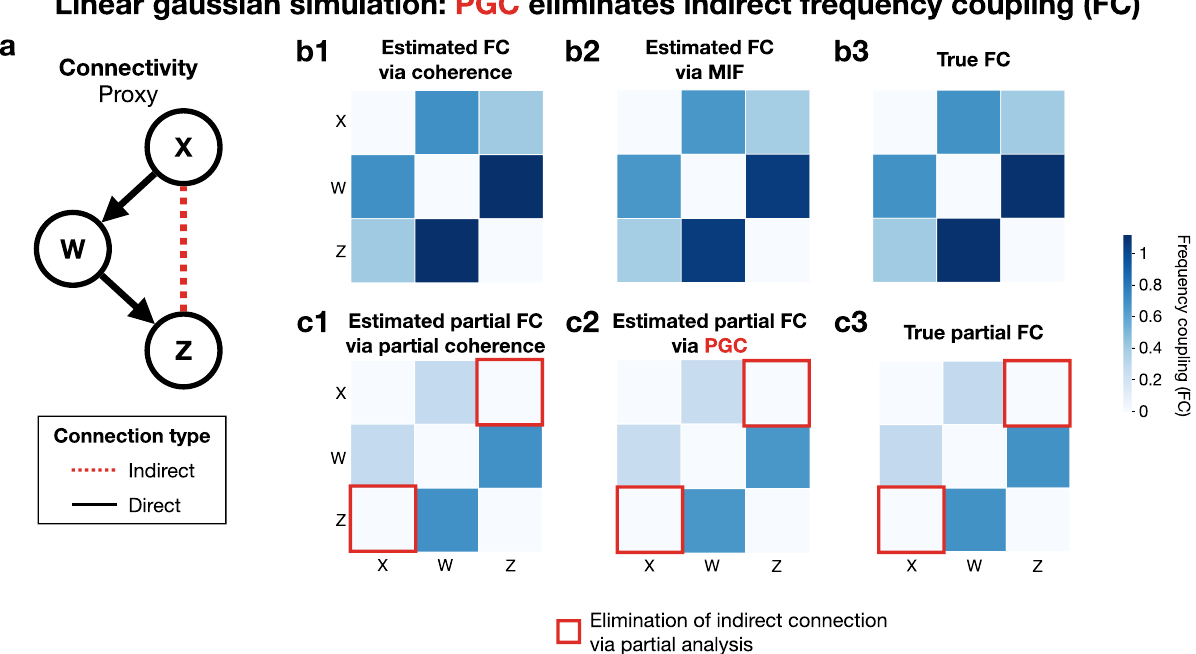
Figure 3. Linear interactions between simulated Gaussian processes. ( a ) Diagram of connectivity between processes X , W , and Z for f 0 . This proxy configuration (Fig. 1a) induces an indirect connection between X and Z . ( b ) Pairwise analyses of same-frequency coupling between processes for frequency f 0 . ( b1 ) Frequency coupling (FC) estimate via transformed partial coherence (8). ( b2 ) FC estimate via MIF (7). ( b3 ) Analytical true FC, demonstrating FC estimation accuracy via coherence in ( b1 ) and MIF in ( b2 ). However, both pairwise methods ambiguously identify the indirect connection between X and Z . ( c ) Application of partial FC methods eliminates this indirect connection, revealing the direct connectivity structure. ( c1 ) Estimated partial FC via transformed partial coherence (11). ( c2 ) Estimated partial FC via PGC. ( c3 ) Analytic partial FC, which demonstrates estimation accuracy of partial coherence in ( c1 ) and PGC in ( c2 ). Heatmaps generated via seaborn 48